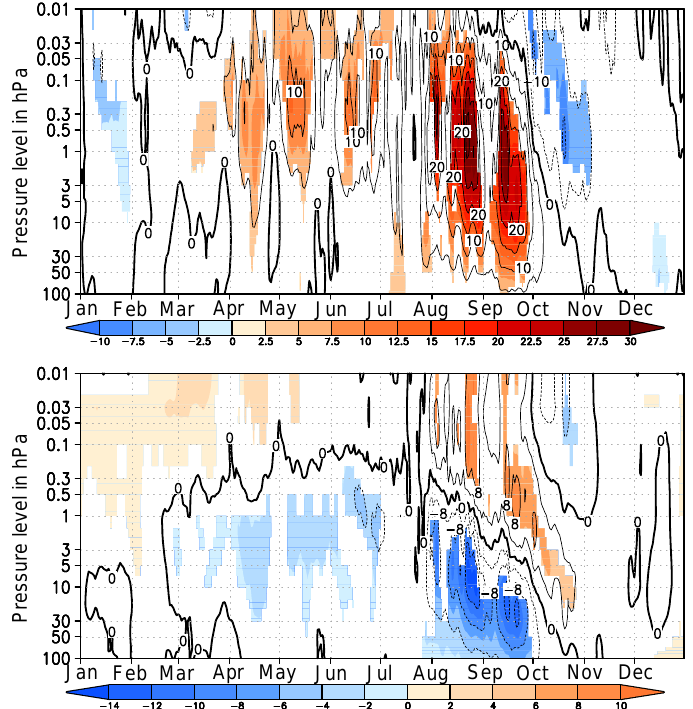
Figure 1. Differences of the daily mean climatology (19 years) between a T42L47MA EMAC simulation with the gravity wave parameter rmscon set to 0.92 and a simulation where it is set to 0.96; for the zonal mean zonal winds at 60 ◦ S in ms − 1 (top); for the zonal mean temperatures averaged from 71.2 to 87.9 ◦ S in K (bottom). The shading indicates the differences that are significant at the 95% level, estimated with a Student’s t